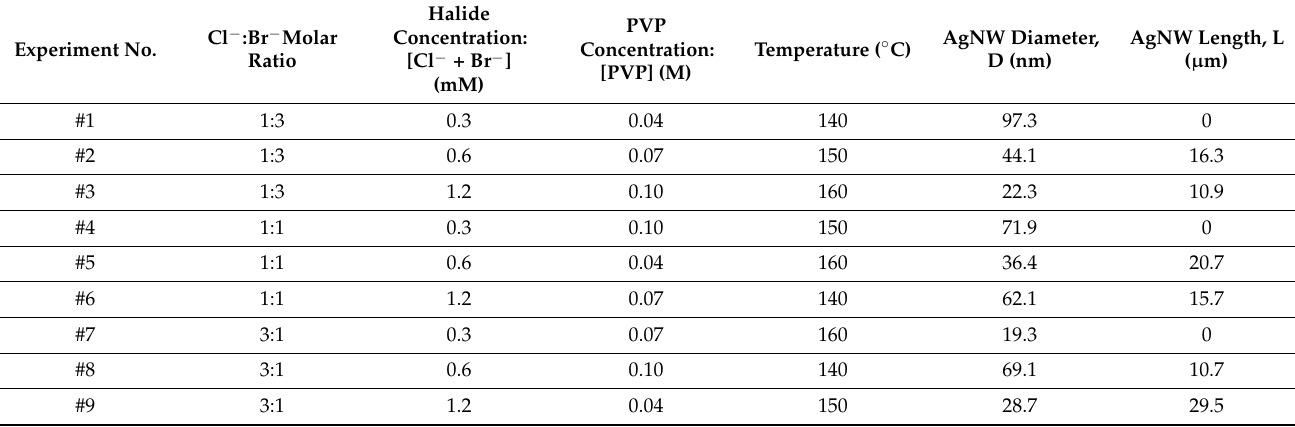
Table 2. Synthesis parameters and dimension of the AgNWs from Taguchi L9 (3ˆ4) orthogonal array.